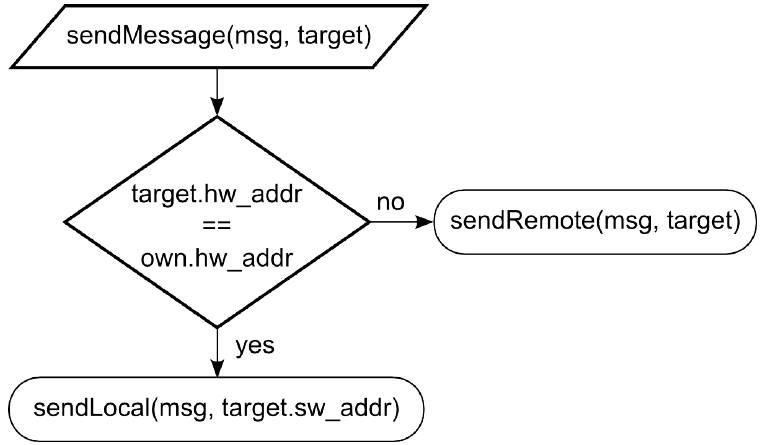
Figure 4. Routing principle in MR